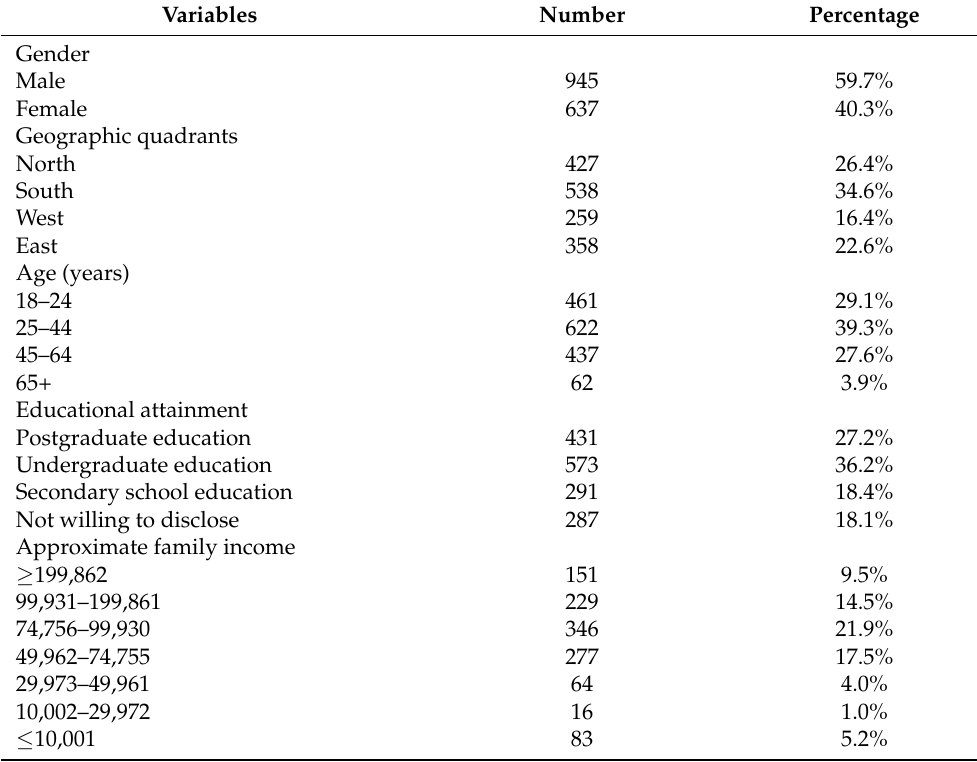
Table 1. Sociodemographic characteristics of the study population used to determine vaccine hesi- tancy, India, 2021 ( n =